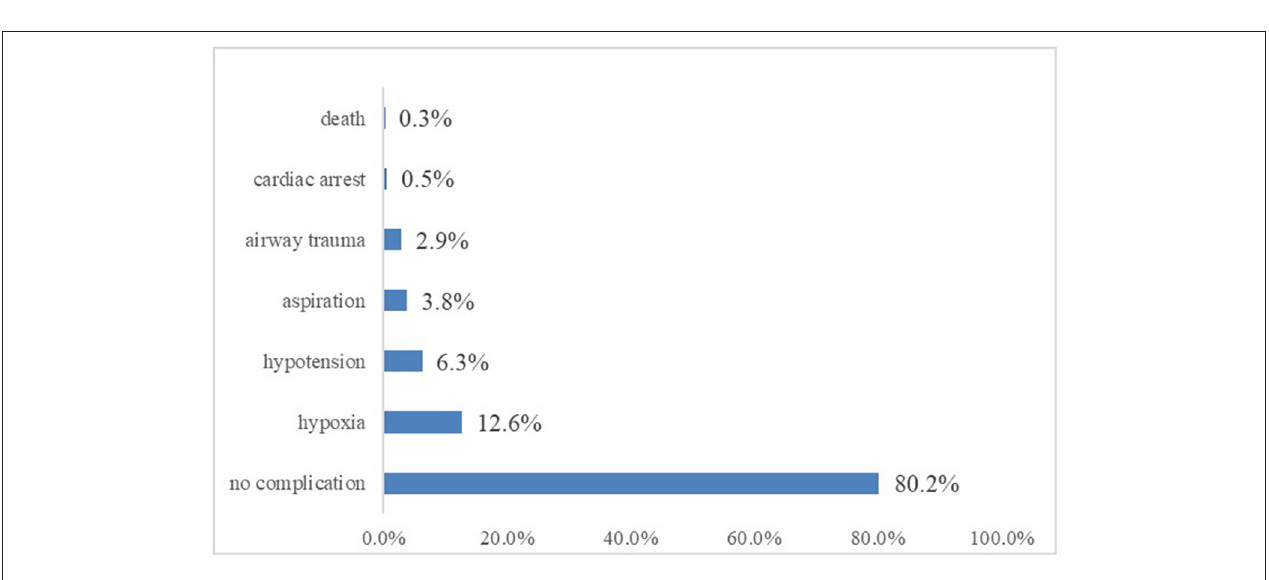
FIGURE 5 | Incidence of different complications during ED